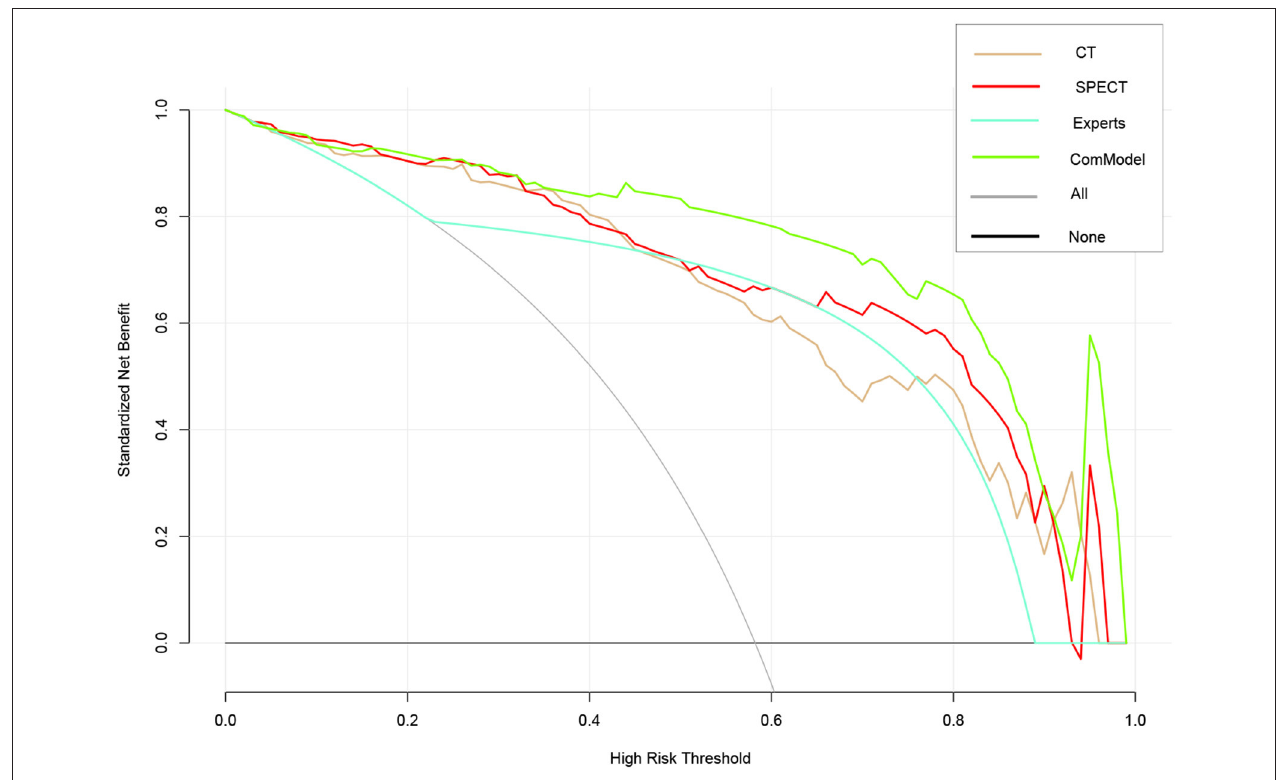
FIGURE 5 | Comparison of decision curve analysis (DCA) of different models. When the threshold was 0–1, the ComModel always had a better overall net clinical gain than the other models, the SPECT model also had higher clinical gain than the human experts, and there was no significant difference between the CT model and the human experts.